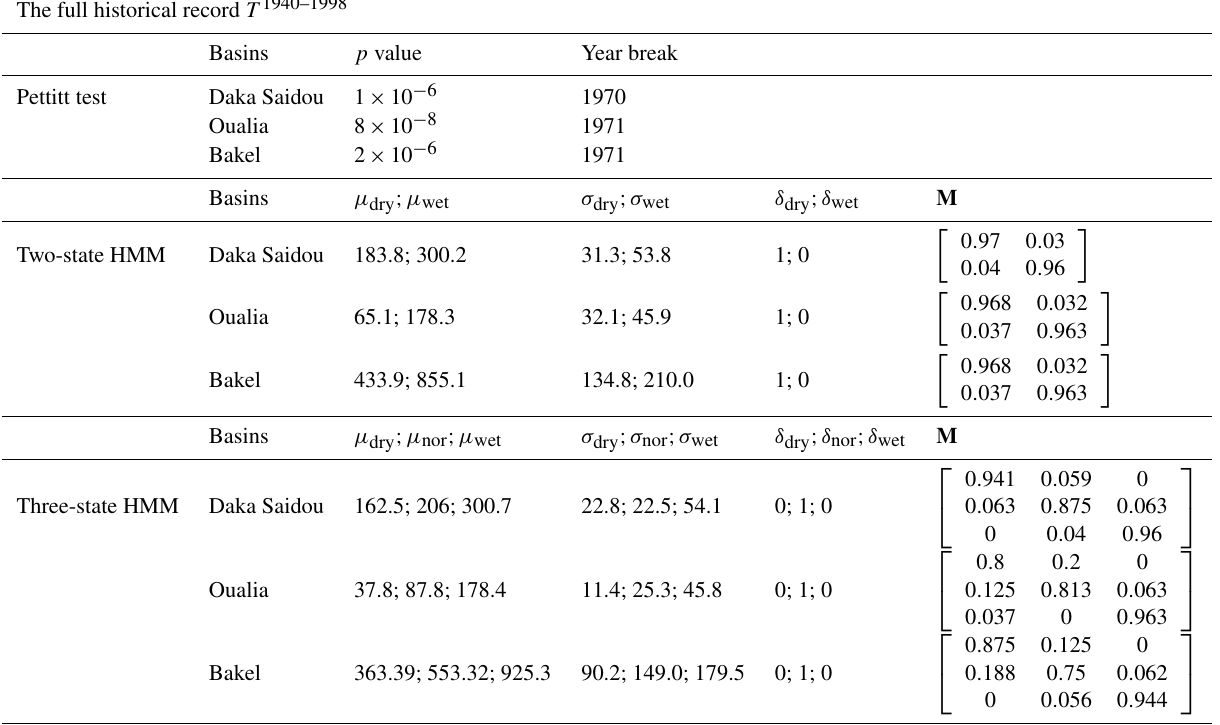
Table 2. Pettitt test results and hidden Markov model parameters ( N = 2 and N = 3) for Daka Saidou, Oualia, and Bakel sub-basins, on the full historical record T 1940–1998